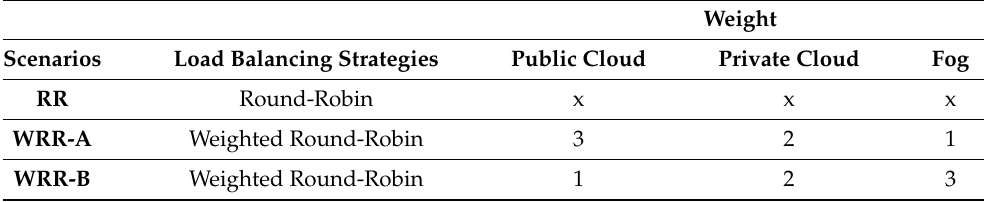
Table 5. Explored scenarios in the analysis of the load balancing